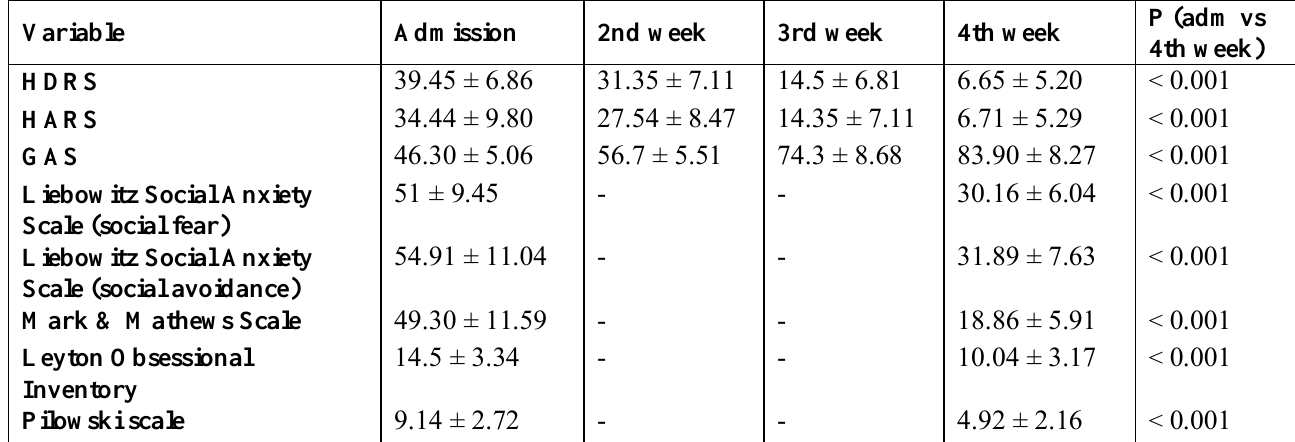
Table 2. Psychopathological assessment: admission and